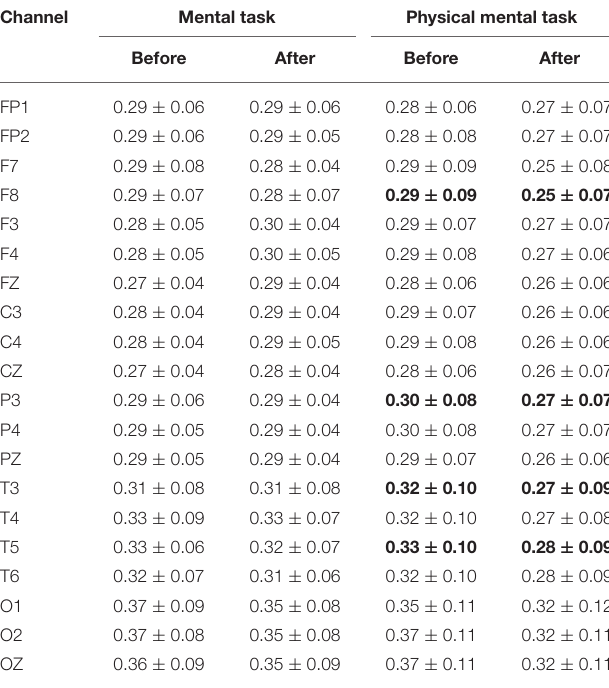
TABLE 5 | LZC for mental and physical mental tasks. Channel Mental task Physical mental